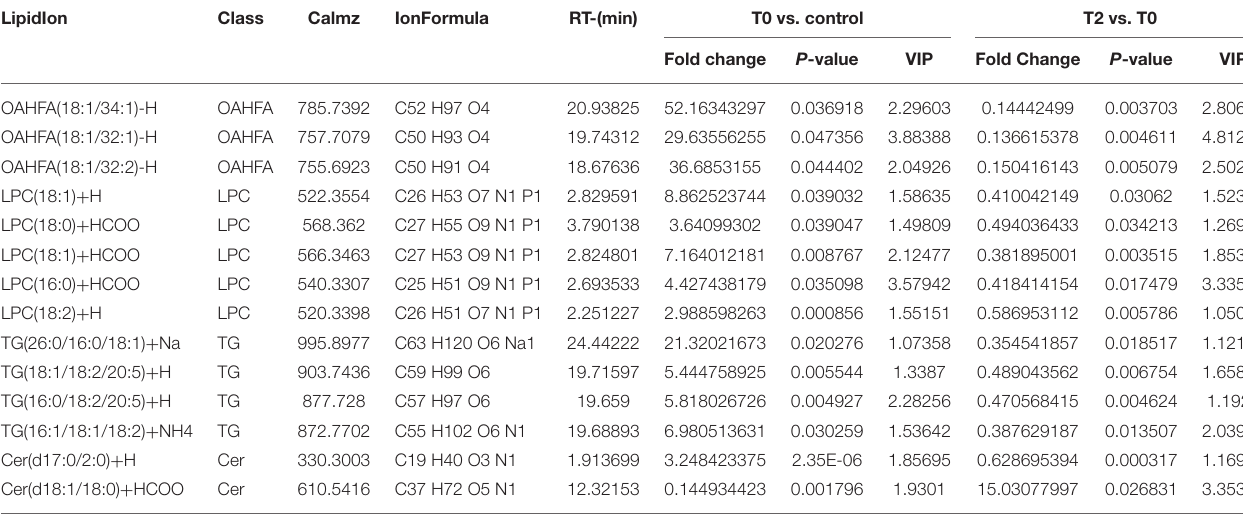
TABLE 4 | Significant different subclasses of lipids of T0 ( n = 26) verse control ( n = 10) and T2 ( n = 26) verse T0 ( n = 26). LipidIon Class Calmz IonFormula RT-(min) T0 vs. control T2 vs. T0 Fold change P -value VIP Fold Change P -value